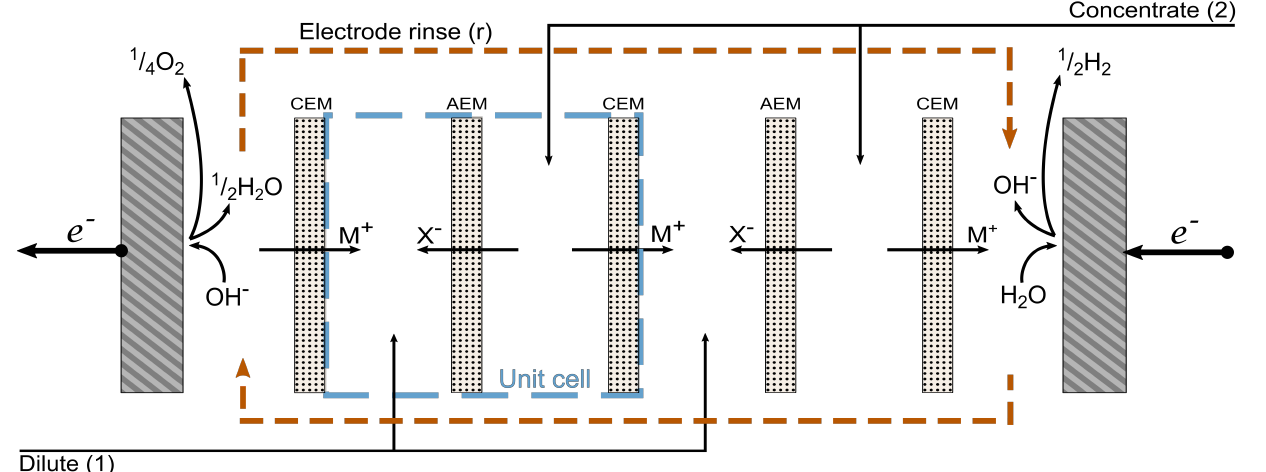
Figure 1. The RED stack showing local flux directions of cations (M + ) and anions (X – ) through the cation-exchange membranes (CEMs) and anion-exchange membranes (AEMs). Concentrate (2) and dilute solutions (1) flow in counter-current directions, and electrode compartments at each end of the stack are filled with a circulating rinse solution (r). The smallest repeating pattern of solutions and membranes is referred to as a unit